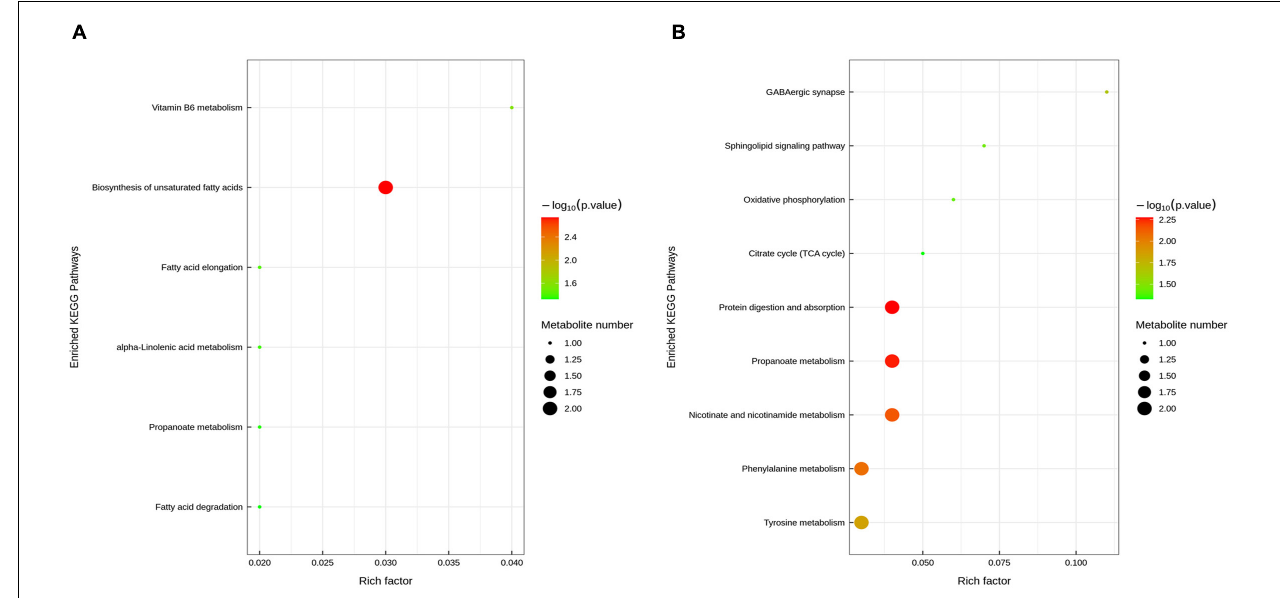
FIGURE 8 | Enriched Kyoto Encyclopedia of Genes and Genomes (KEGG) pathway enrichment based on altered metabolites. The color of the point was P -value, and the redder, the more significant enrichment. The size of the spot represented the number of different metabolites enriched. Control vs ETEC group (A) ; ETEC + HNa vs ETEC group (B)